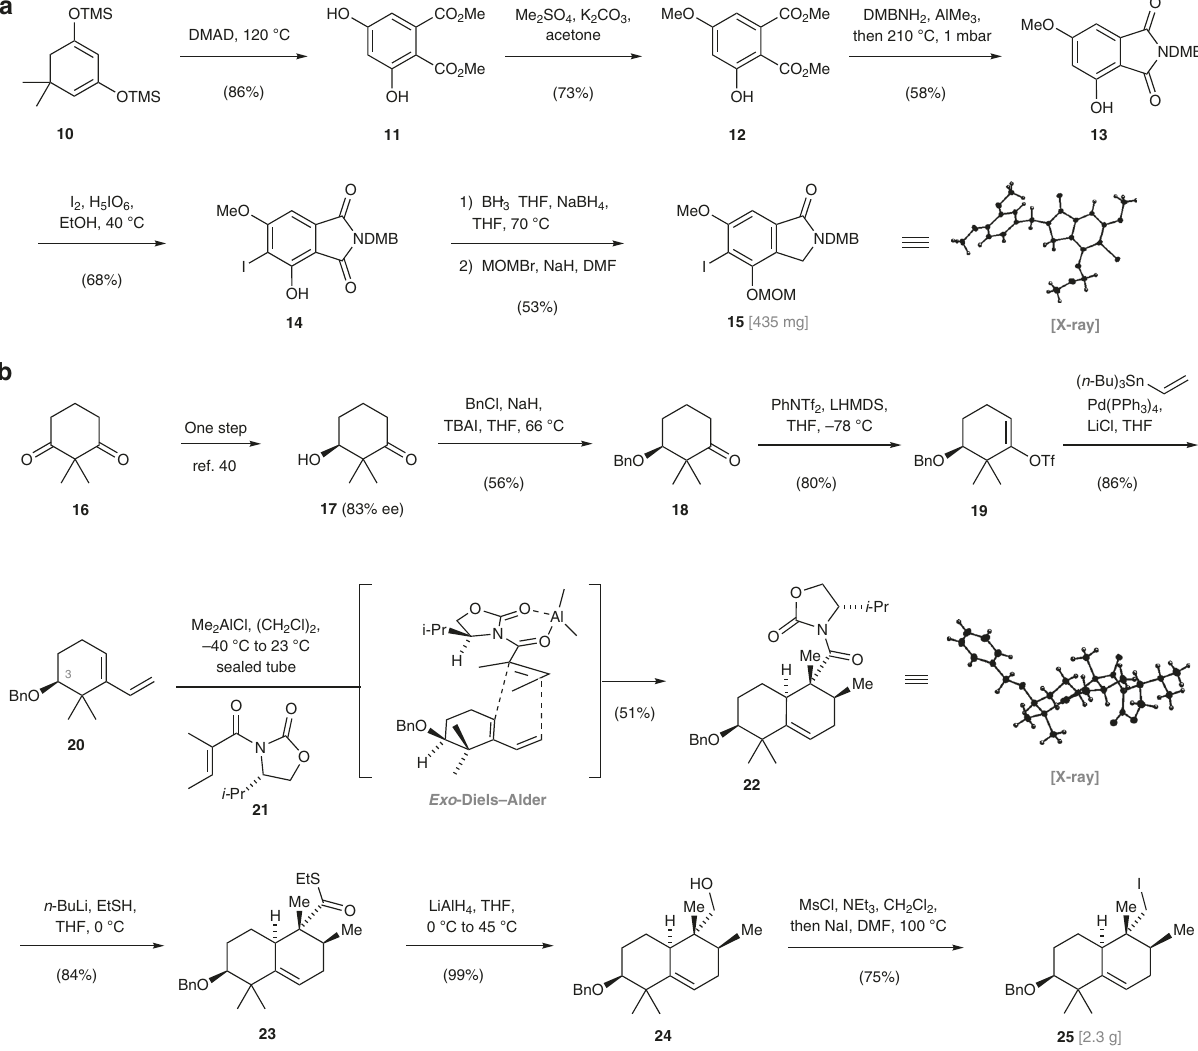
Fig. 3 Synthesis of the isoindolinone component 15 and the dehydrodecalin 25 . a The developed de novo synthesis of isoindolinone 15 proceeds in six linear steps and only involves crystalline intermediates. b For the construction of the 5,6-dehydrodecalin 25 , an auxiliary-controlled exo -selective Diels – Alder cycloaddition was employed. This allowed the production of 25 in eight steps in gram quantities in a single batch. DMAD dimethyl acetylenedicarboxylate, n -Bu n -butyl, Bn benzyl, DMB 3,4-dimethoxybenzyl, DMF N , N -dimethylformamide, LHMDS lithium hexadimethylsilazide, MOM methoxymethyl, Ms methanesulfonyl, TBAI tetrabutylammonium iodide, Tf tri fl uoromethanesulfonyl, THF